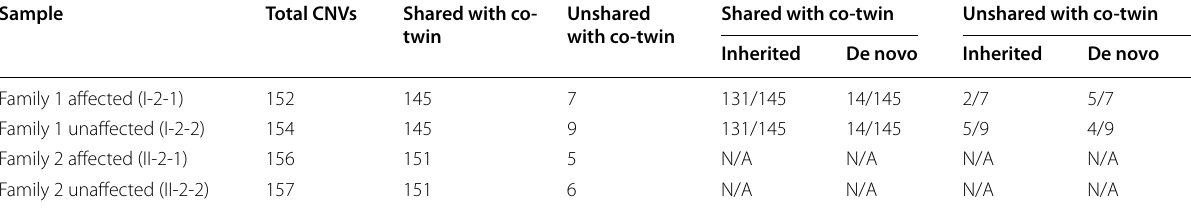
Table 5 Shared and unshared copy number variants (CNVs) as compared to NCBI Build 37 Sample